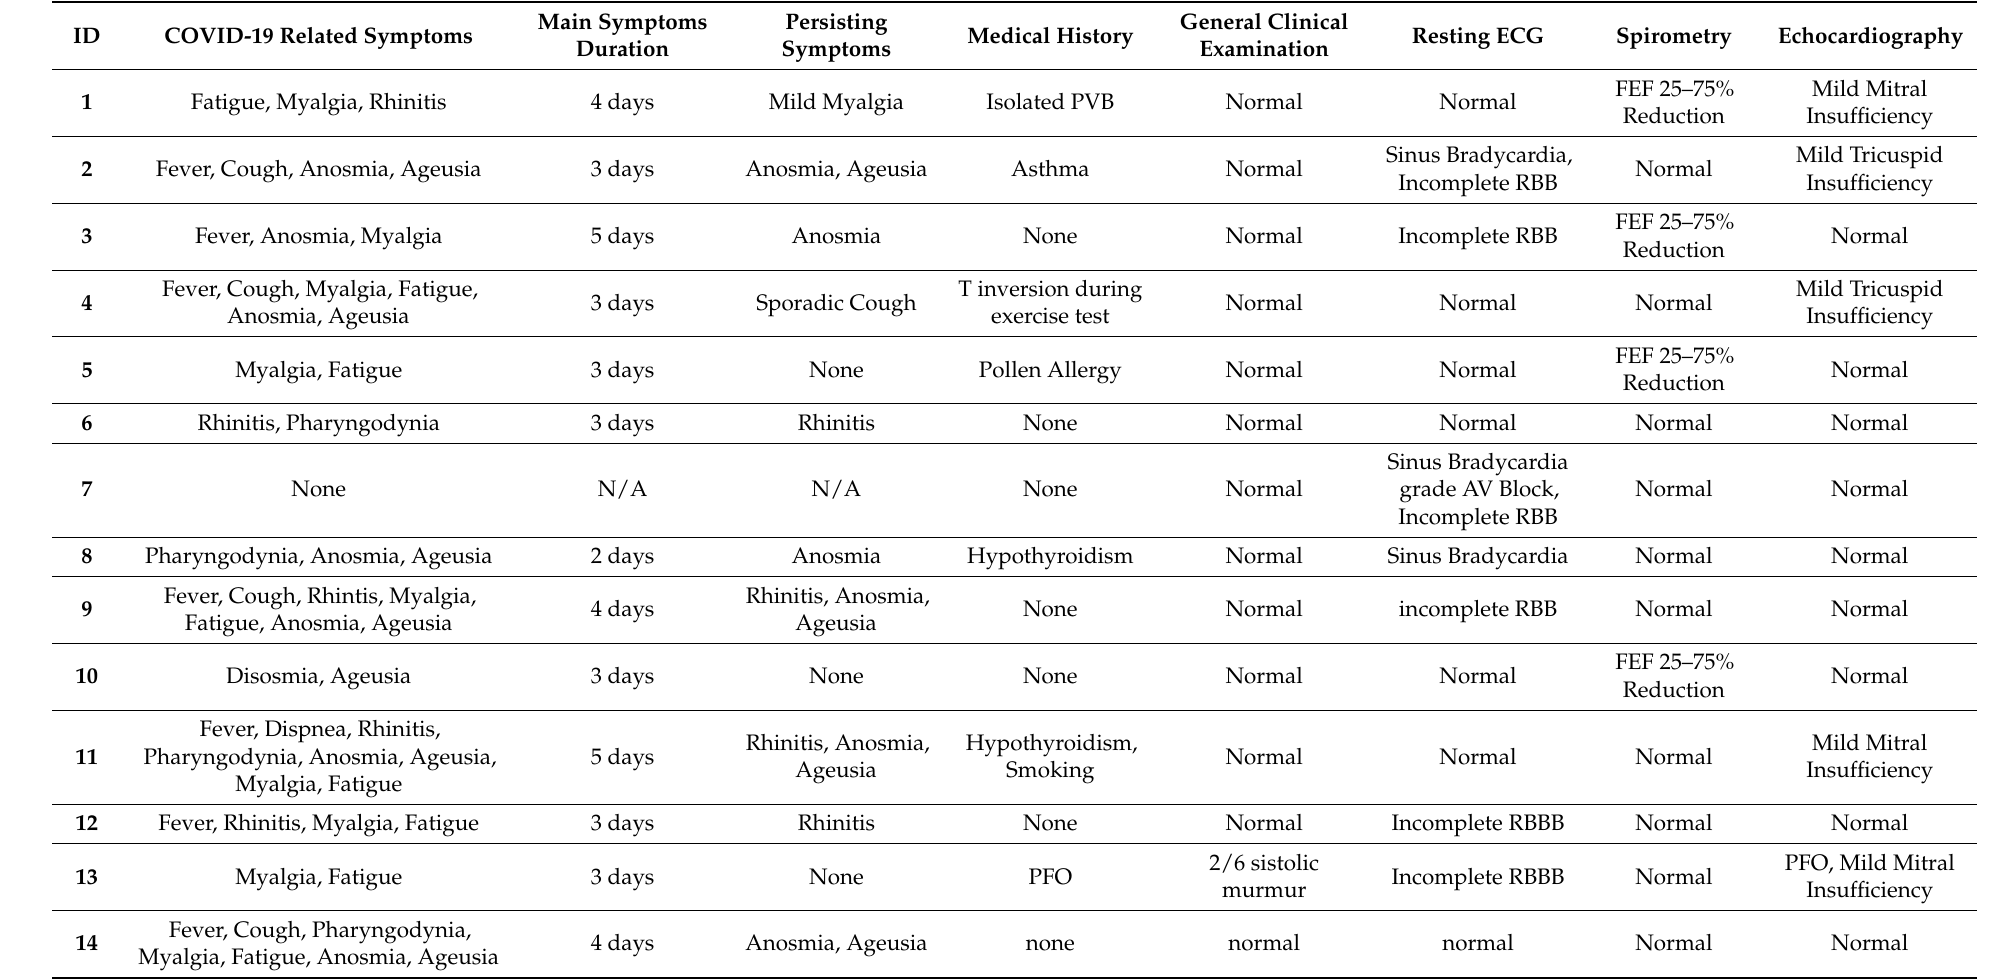
Table 1. Description of clinical and instrumental findings in COVID-19